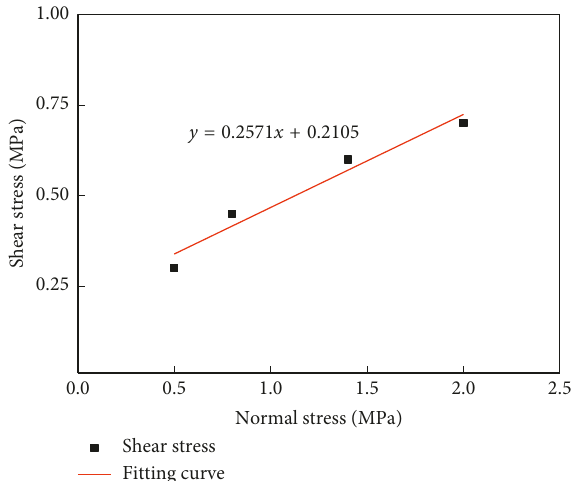
Figure 12: The relationship between the shear stress and the normal stress of the test point #2.